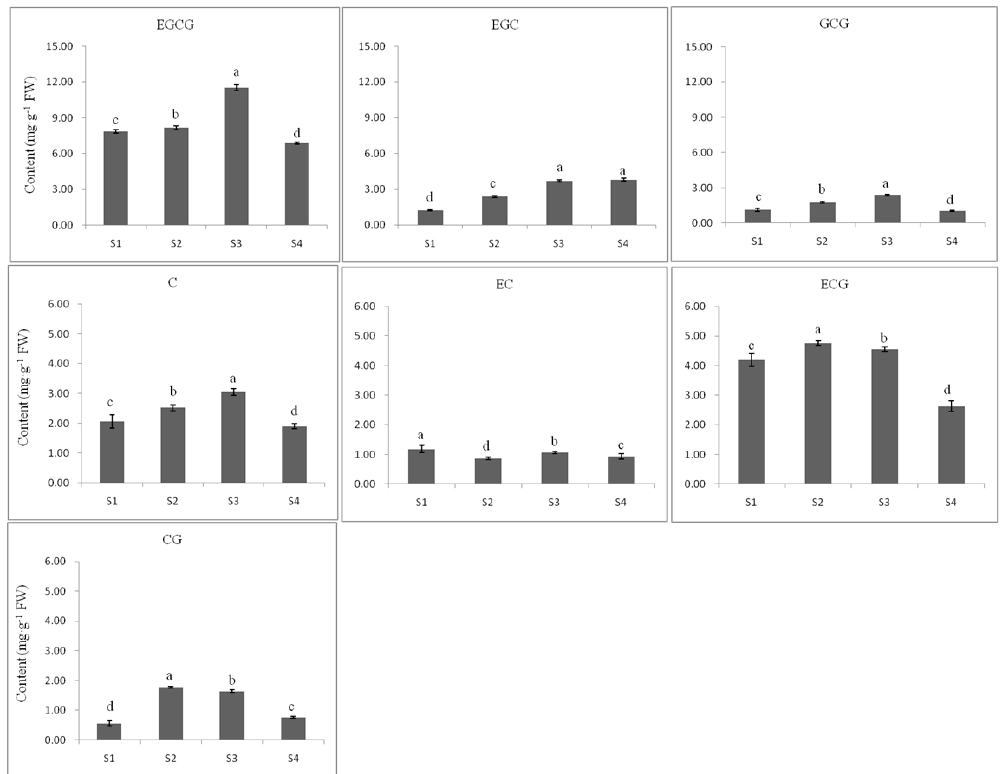
Figure 7. Content of flavan 3-ols in tea seedling at different developmental stages. The data represent the mean ± SD from three independent measurements. Means in each column for each flavan 3-ol labeled with the same letter are not significantly different ( p > 0.05) based on one-way ANOVA with Duncan’s multiple range test.